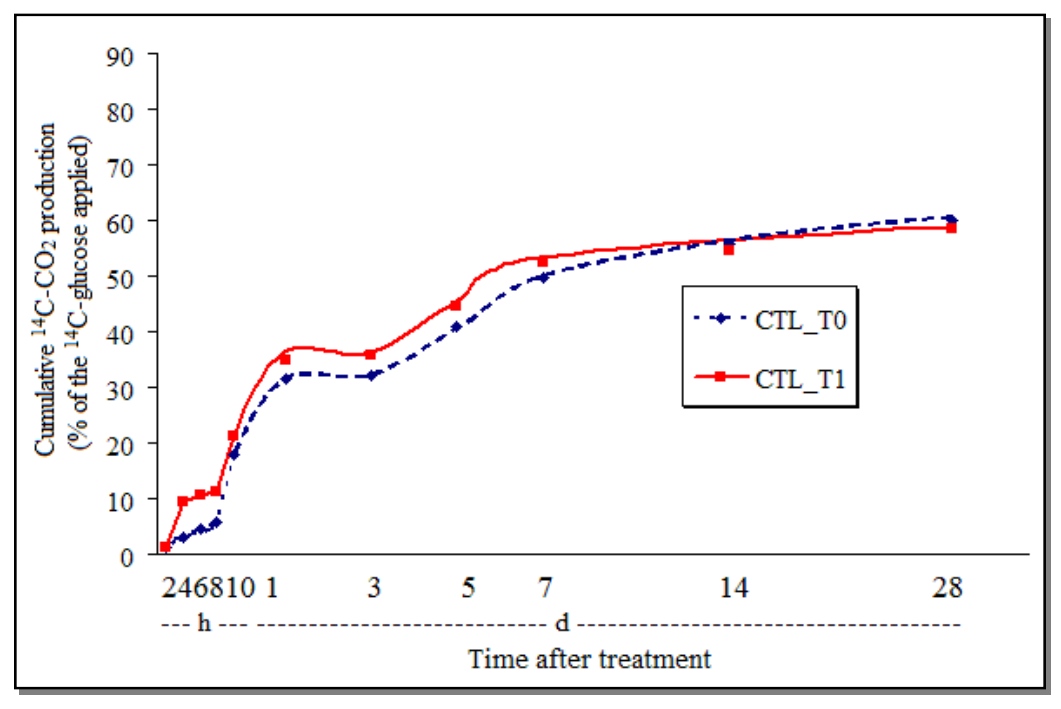
from 14 C-glucose by the soil AVEC treated 2